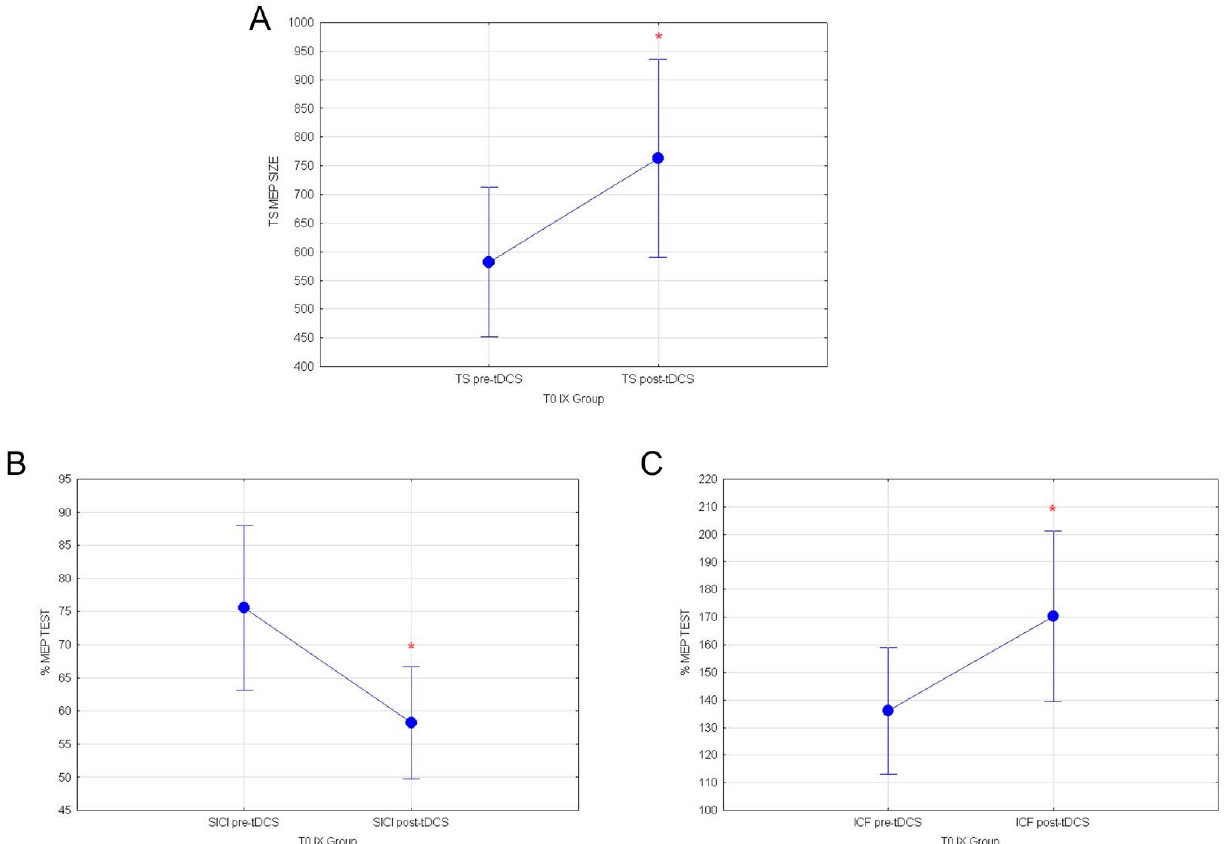
Figure 5. ( A ) MEP values for TEST stimulus, ( B ) normalized % MEP for SICI and ( C ) normalized % MEP for ICF, at T0 for IX group are shown in pre vs. post-TDCS. Vertical bars denote 0.95 confidence intervals. (*) for p < 0.05.